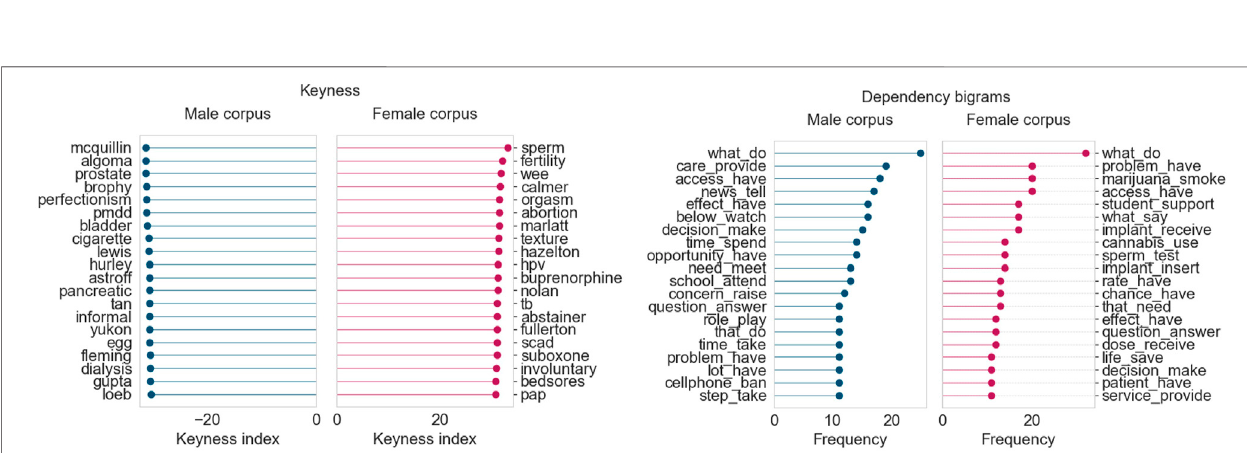
FIGURE 9 | Corpus analysis results for top 200 articles from “ Lifestyle ” (December 2019).